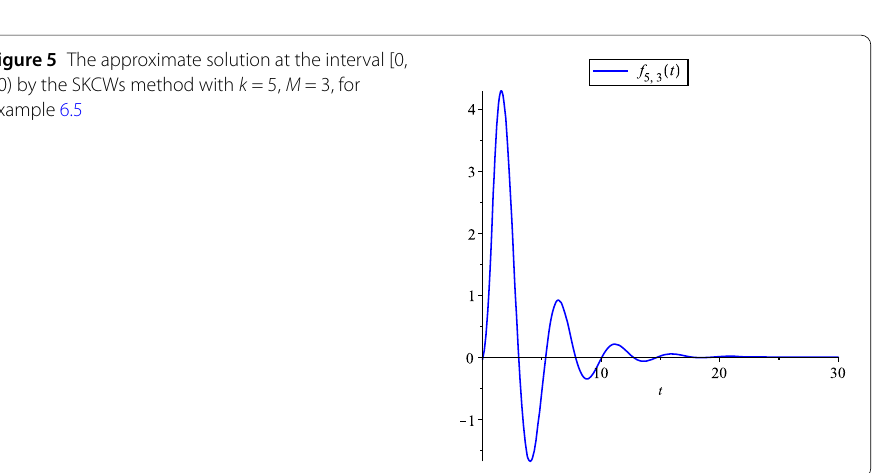
Figure 5 The approximate solution at the interval [0, 30) by the SKCWs method with k = 5, M = 3, for Example